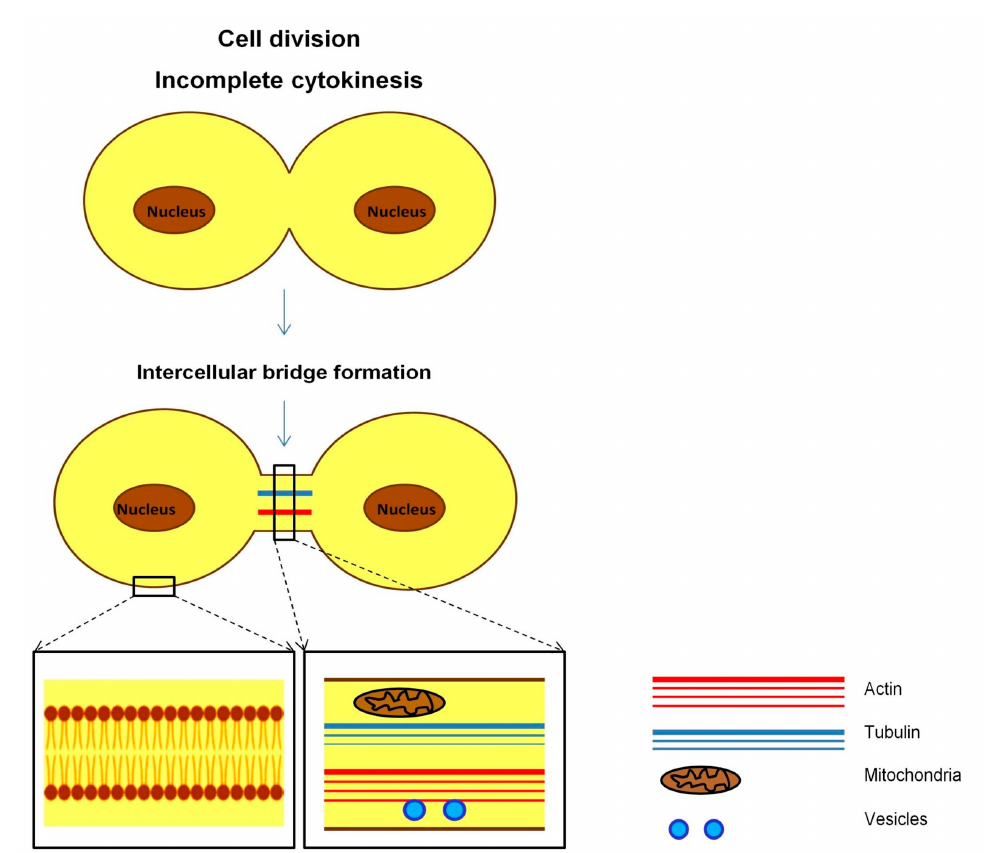
Figure 5. Mechanism of intercellular bridge formation. Intercellular bridges form upon completion of karyokinesis, as a result of incomplete cytokinesis. These structures represent open-ended membrane protrusions, which are shorter but have a much larger diameter compared to TNTs. The transport of organelles and other cellular components inside intercellular bridges occurs unhindered and freely, without increasing the diameters of intercellular bridges in the region of cargo